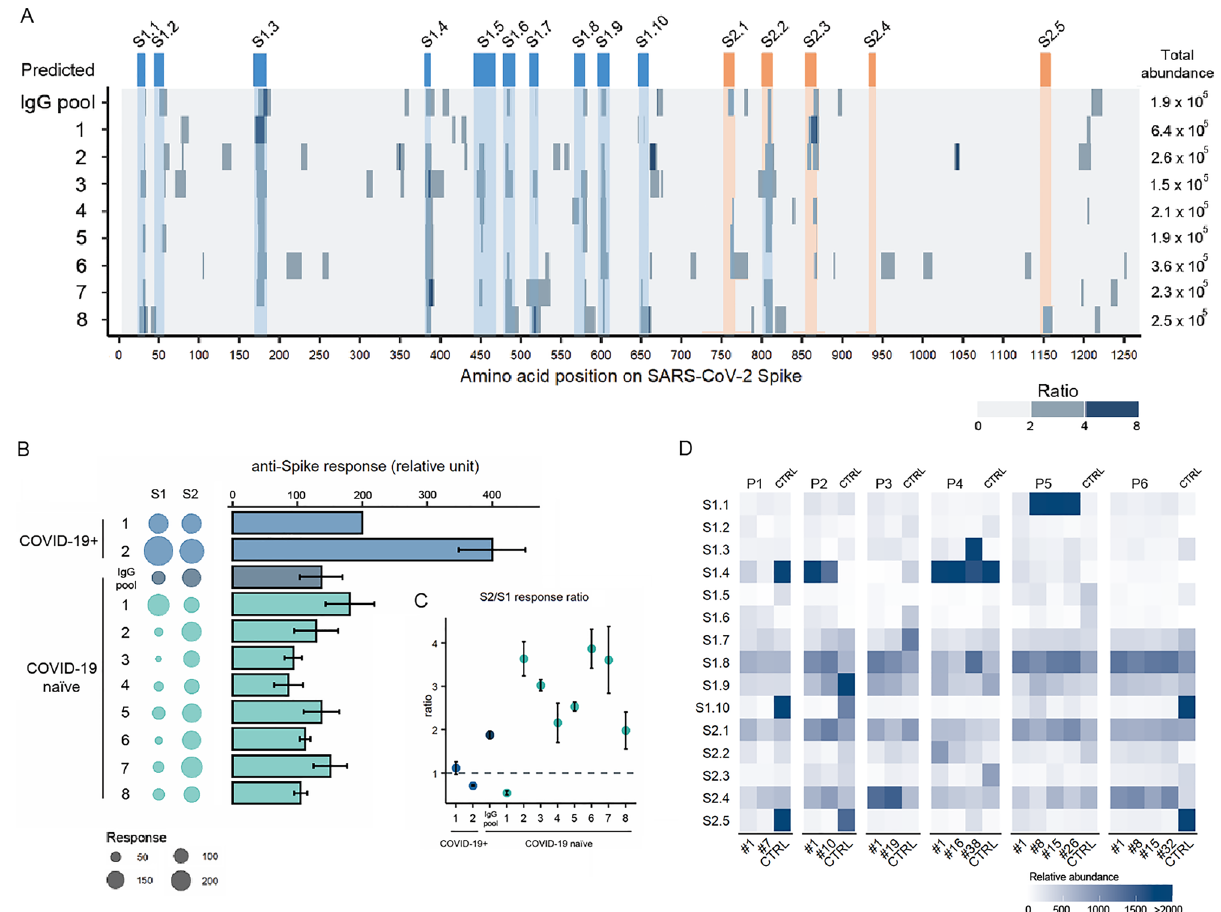
Figure 3. Differential antibody response to SARS-CoV-2 spike protein in COVID-19 diseased and naïve individuals. (A) Individual MVA immunoprofiles of antibody response to 15 epitopes of SARS-CoV-2 S in COVID-19 naïve samples shown as a ratio of specific vs random alignments. Ratios are visualised as centred moving averages across 9 amino acids. Y-axis—identifiers of samples, IgG pool refers to human pooled IgG sample, numbers 1–8 refer to COVID-19 naïve subjects (same as in B,C ), Predicted—MVA-delineated epitopes on SARS-CoV-2 S; S1.1 to S1.10—epitopes on subunit 1 of S (dark blue); S2.1 to S2.5—epitopes on subunit 2 of S (orange colour); total abundance—calculated total abundance of IgG-bound peptides aligned to S per individual sample; colour bar (ratio)—ratio of alignment loads of specific vs random (scrambled) IgG-bound peptide sets. ( B) Seroreactivity of COVID-19 naive (n = 8) and COVID-19 patients (n = 2) to spike protein subunits S1 and S2. 50 ng of SARS-CoV-2 S protein recombinant subunits S1 and S2 were immobilised on nitrocellulose slides and incubated with human serum/plasma samples to measure immunoreactivity to SARS- CoV-2 spike protein. Samples (n = 8) of selected subjects from COVID-19 naïve cohort (COVID-19 naïve 1–8) were used, alongside with the pooled human IgG sample (IgG pool, n = 2700 individual healthy donors, Sigma-Aldrich, # I4506). Samples (n = 2) taken at hospital intensive care admittance from patients (P1#1, P2#1) diagnosed with COVID-19 were included as positive controls for anti-spike immunoreactivity (COVID-19+ , 1–2). Dots represent dot-ELISA data normalised to the sample from patient 1 (P1#1) (COVID-19+) separately for S1 and S2 subunits (100 represents 100%). Bar plot shows the sum of average of dot-ELISA results for S1 and S2 from independent experiments (n = 3). Error bars represent summarised SEM from independent S1 and S2 results. ( C) Scatter plot depicts average ratio of SARS-CoV-2 S2 and S1 signals in dot-ELISA experiments (n = 3) from ( B) . Error bars represent SEM. ( D) Heatmap shows the abundance of IgG-bound peptides containing the 15 epitopes of SARS-CoV-2 S protein in COVID-19 patients and controls. MVA immunoprofiles of serial samples from COVID-19 patients (n = 6) at different time points, where #1 is the sample taken at time of hospital admittance and “#n” where n designates the number of days from the first sample withdrawal. CTRL (n = 6) are age- and gender-matched healthy subjects selected from the cohort of 538 people. Relative abundance depicts the abundance of IgG-bound peptides containing the corresponding S epitopes, where values above 2000 are capped to